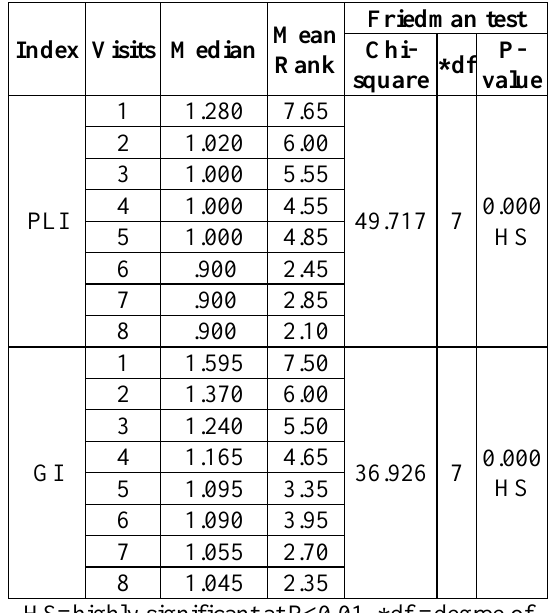
Table 1: Descriptive and statistical test of Plaque index (PLI) and Gingival index (GI) change during visits.